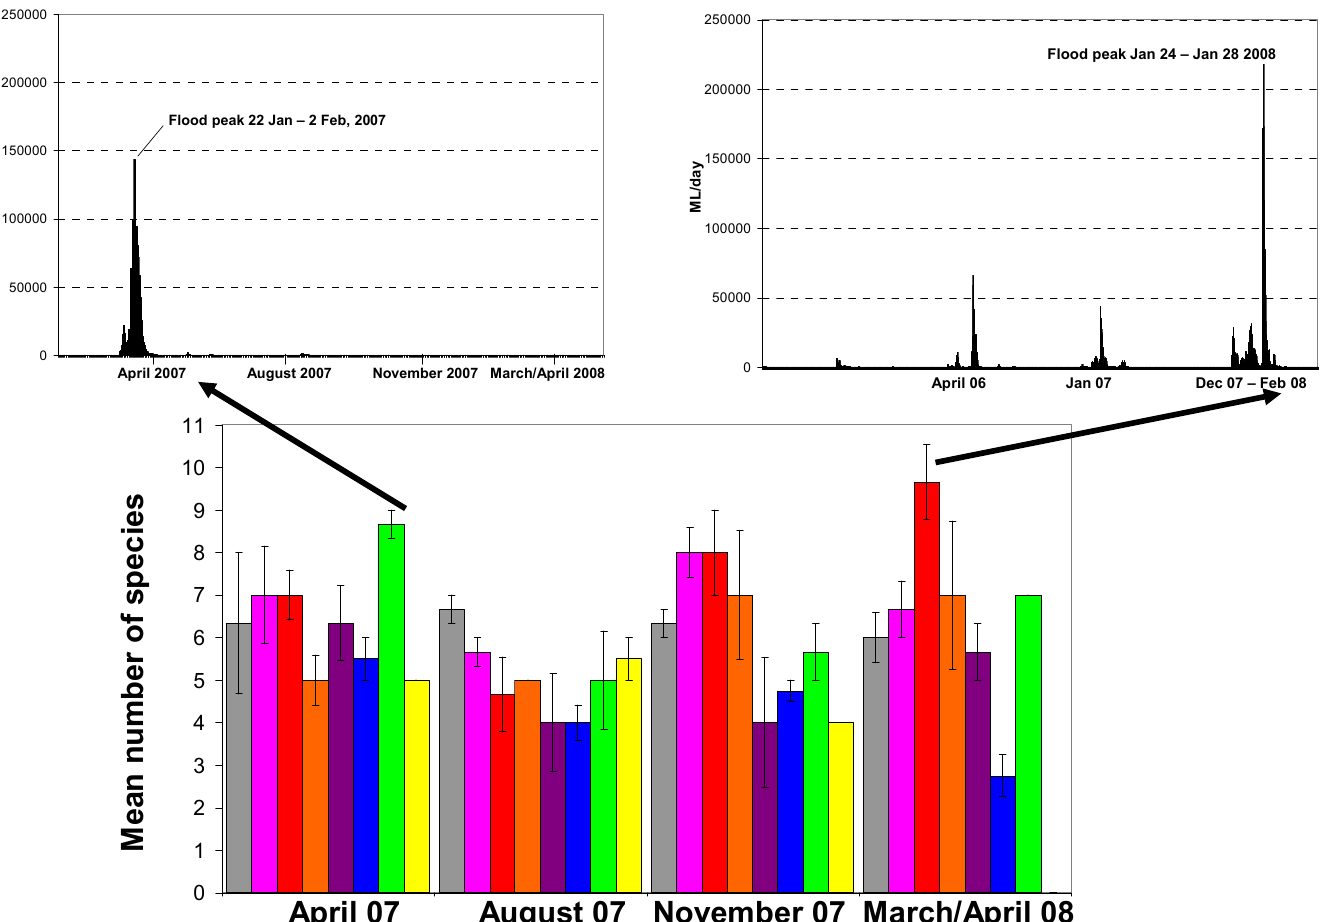
Figure 2. Mean (±S.E.) number of species sampled in the Bulloo (grey bars), Kyabra (pink bars), Cooper (red bars), Thomson (orange bars), Barcoo (purple bars), Diamantina (blue bars), Georgina (green bars) and Mulligan catchments (yellow bars) in April 2007, August 2007, November 2007 and March/April 2008 (bottom) . Hydrographs of the Georgina River at Roxborough Downs ( top left ) and Cooper Creek at Retreat ( top right ) show major flooding in these catchments in January 2007 and January 2008 respectively, and arrows indicate the highest species richness in both catchments occurring after major flood